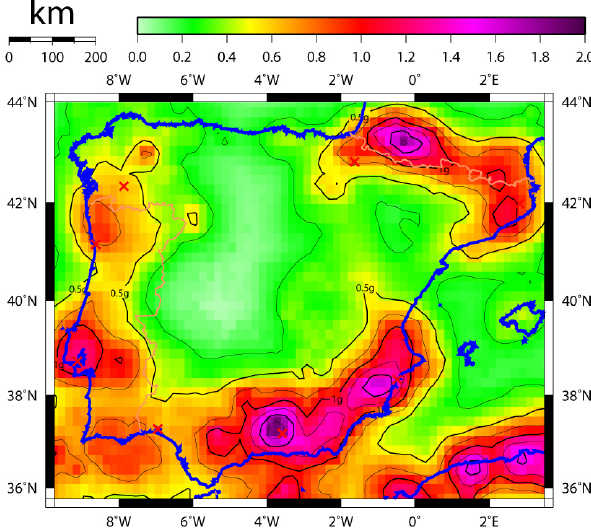
Figure 12. Distribution of the accelerations obtained for T = 0 . 1s and 2475yr return period.